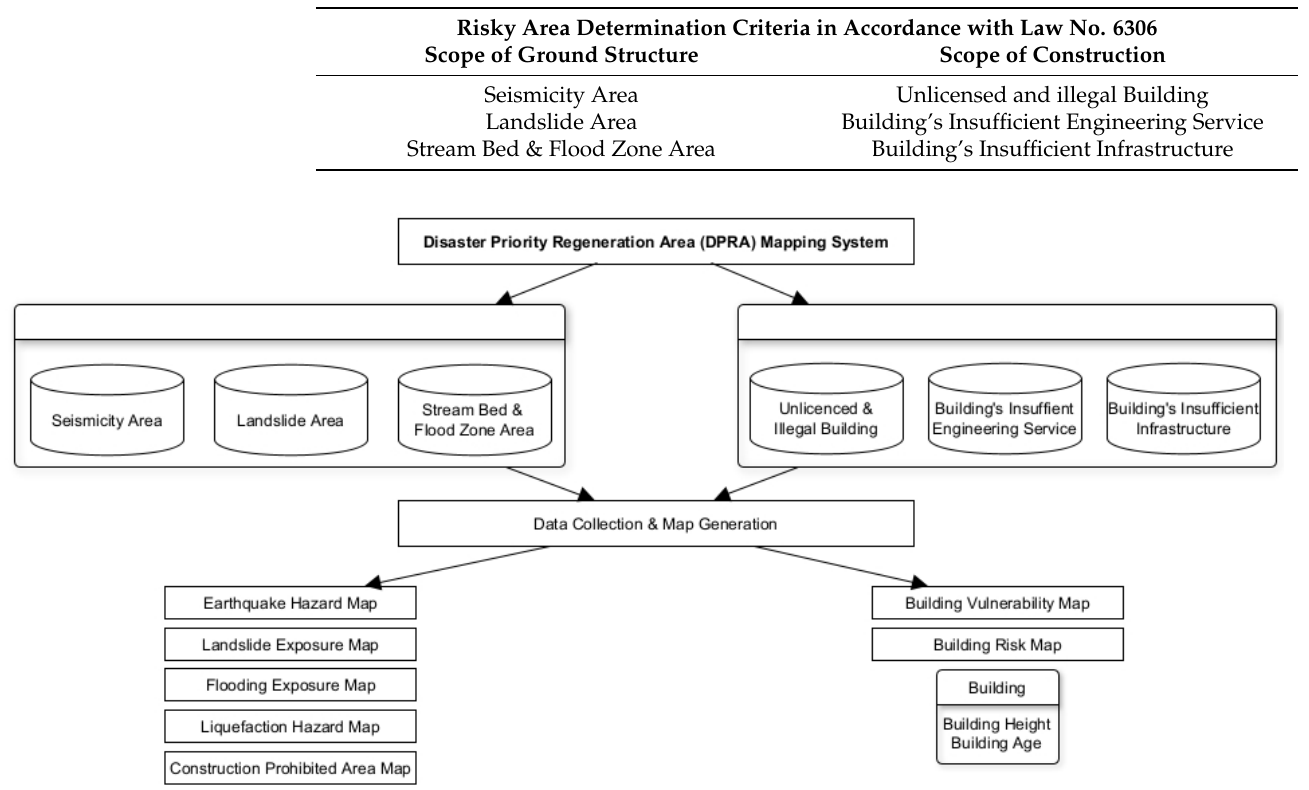
Figure 7. Data set Schema of DPRA Mapping System.